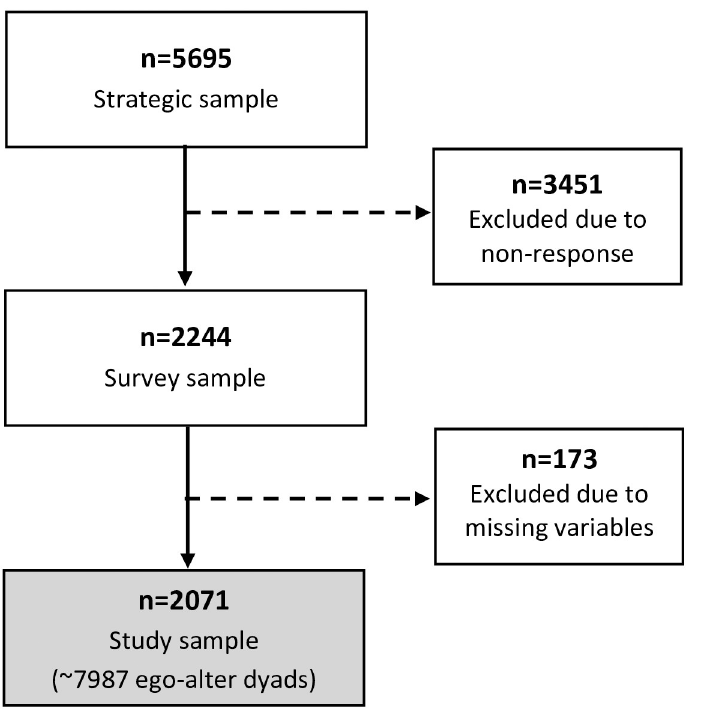
Fig 1. Flow diagram of study sample